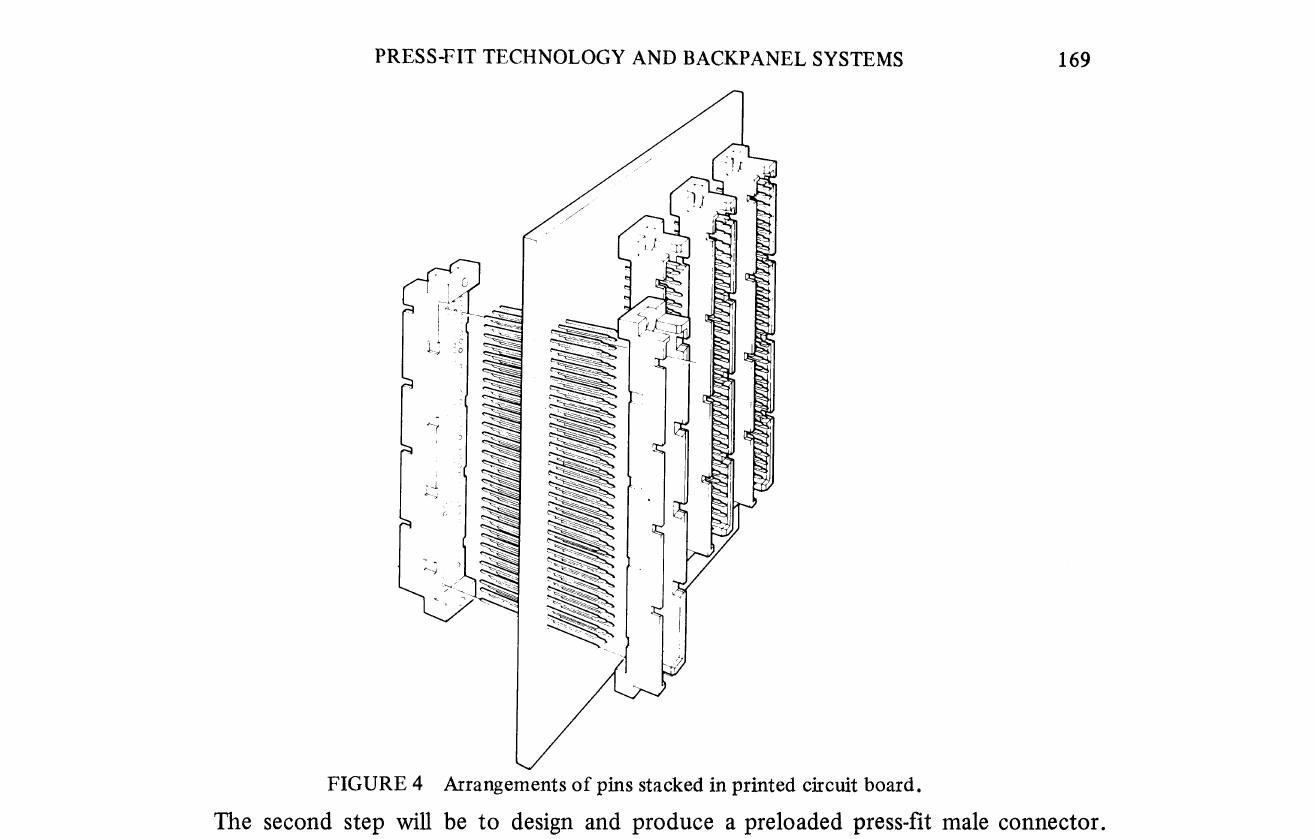
FIGURE 4 Arrangements of pins stacked in printed circuit board.